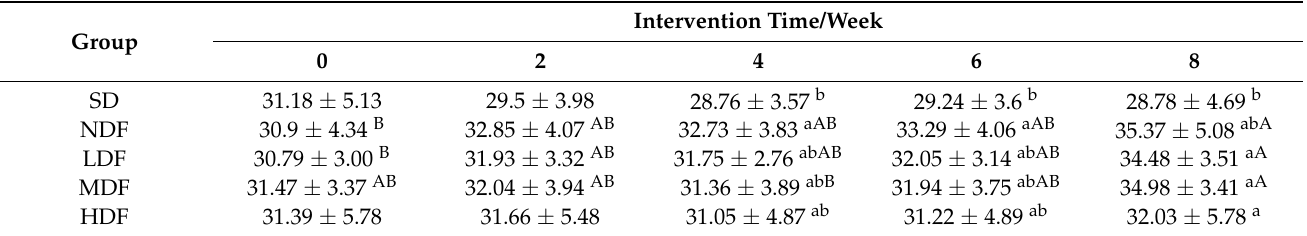
Table 2. Effect of CDFC on body weight of aging mice.